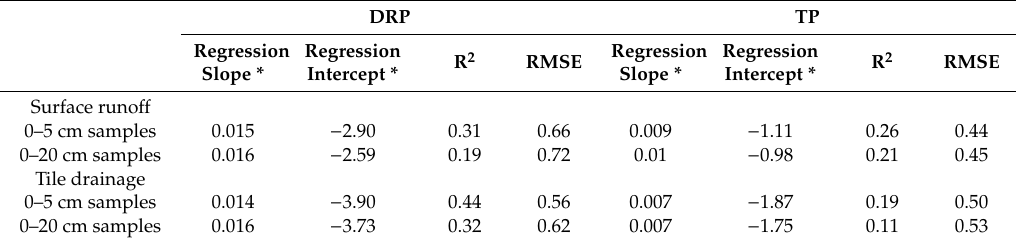
Figure 1. Regression relationships between soil test P (STP) and flow-weighted mean dissolved reactive P (FWM DRP) concentrations. Surface runo ff FWM DRP vs. STP in the ( A ) agronomic soil horizon (0–20 cm) and ( B ) the shallow soil horizon (0–5 cm). Tile drainage FWM DRP vs. STP in the ( C ) agronomic soil horizon and the ( D ) shallow soil horizon. Regressions were performed on log transformed runo ff P concentrations; data are plotted in original units with log-scale x-axis. Table 3. Regression results for field average soil test P vs. flow weighted mean dissolved reactive P (DRP) and total P (TP) concentrations. Regressions were performed on natural log transformed FWM P